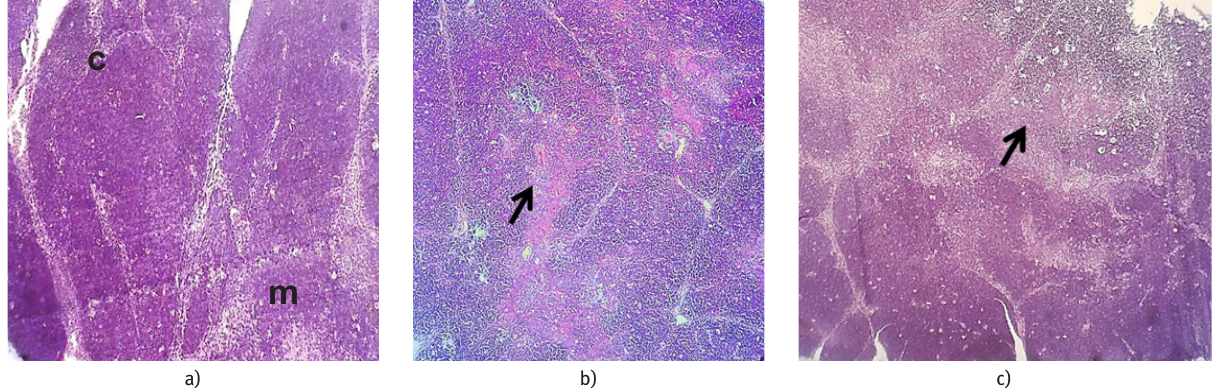
Figure 4: Photomicrograph of section of thymus of pigeons post-inoculation and/or exposure to a very virulent infectious bursal disease virus. Note intact cortex (c) and medulla (m) in uninoculated pigeon (a), slight depletion of medulla (arrows) in inoculated (b) and sentinel (c) pigeons. H & E x 200